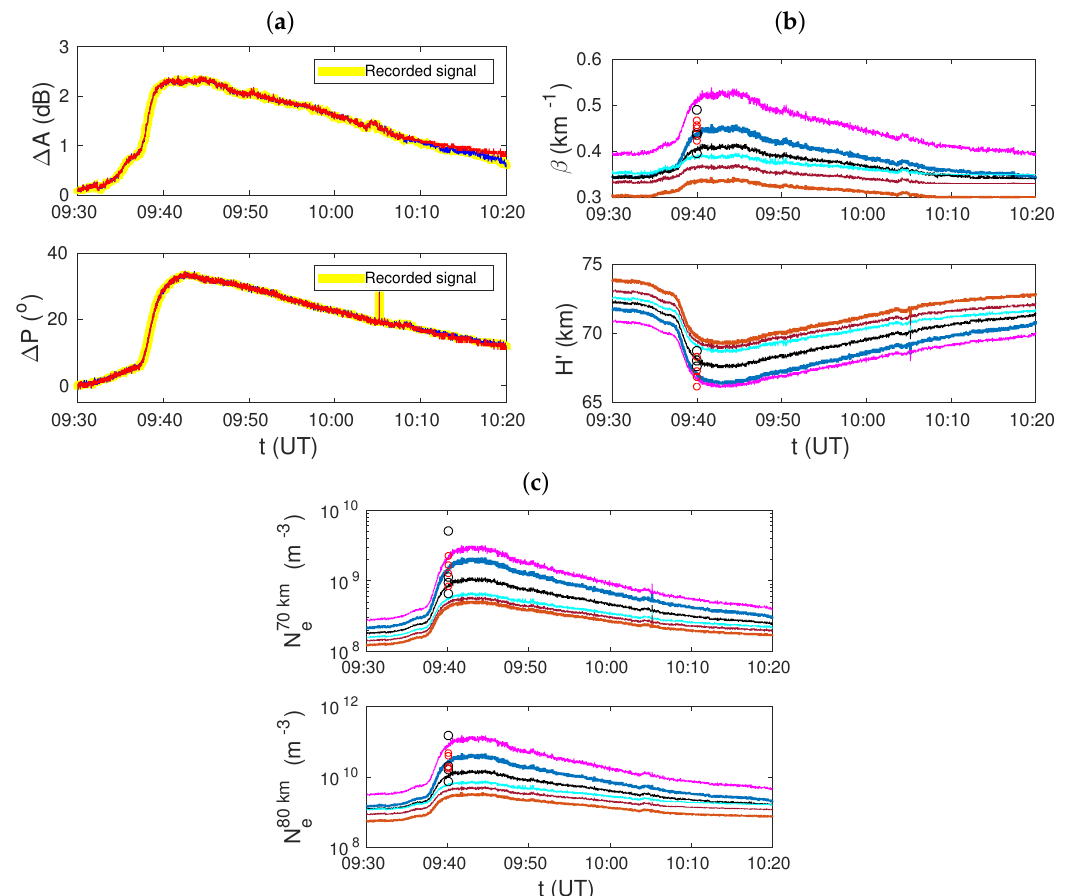
Figure 13. Comparisons for the D-region disturbed by a solar X-ray flare on 17 September 2015. ( a ) Comparisons of time evolutions of the recorded amplitude (upper panel) and phase (lower panel) changes with their modeled values by the Long-Wave Propagation Capability (LWPC) model for Wait’s parameters β 0 and H (cid:48) determined by the Quiet Ionospheric 0 D-Region (QIonDR) model (blue line) and by default (red line). ( b ) Comparison of time evolutions of Wait’s parameters β and H (cid:48) obtained by the LWPC program for their initial values modeled by the QIonDR, LWPC default and International Reference Ionosphere (IRI) models, and those presented in literature indicated in the legend [22,27,35,52,53]. The values obtained in References [26,29] at the moment of maximum X-radiation flux for flares of the same or very similar class as the considered one are shown by scatters. ( c ) Comparison of time evolutions of the electron density at 70 km (upper panel) and 80 km (bottom panel) for Wait’s parameters shown in graph ( b ). McRae and Thomson, 2004